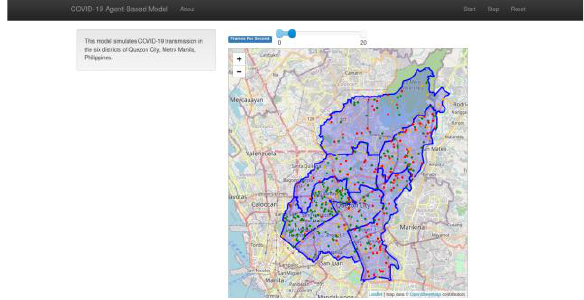
Figure 1. GIS visualization of the agent-based model The agents inside the bounded region interact with each